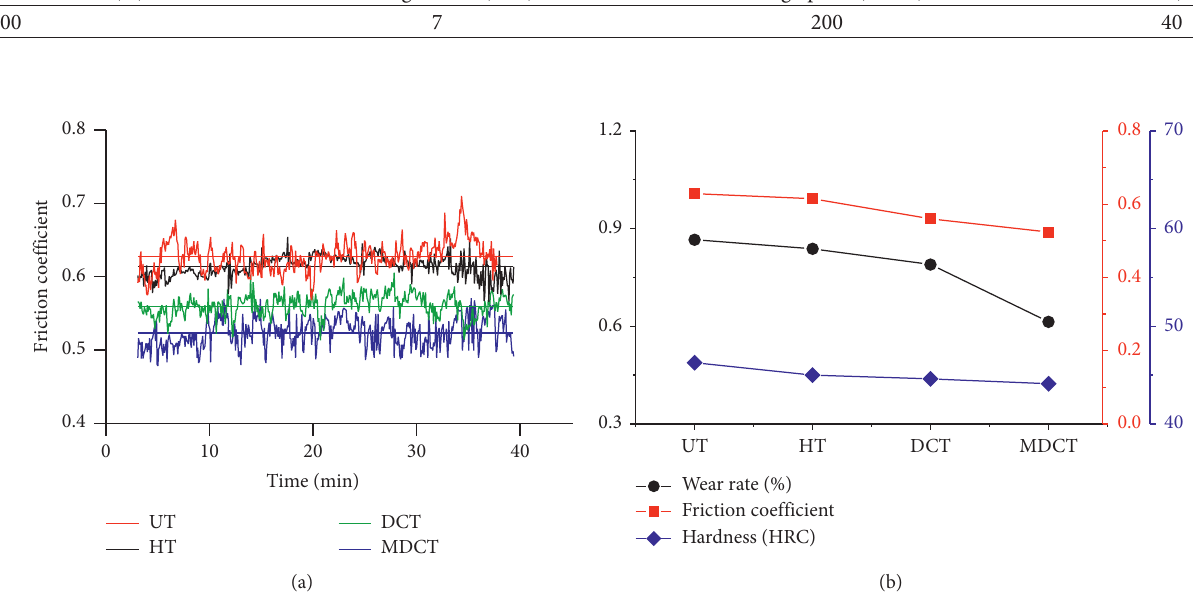
Figure 4: Mechanical property of process groups: (a) Dynamic friction coefficient; (b) wear rate, friction coefficient, and